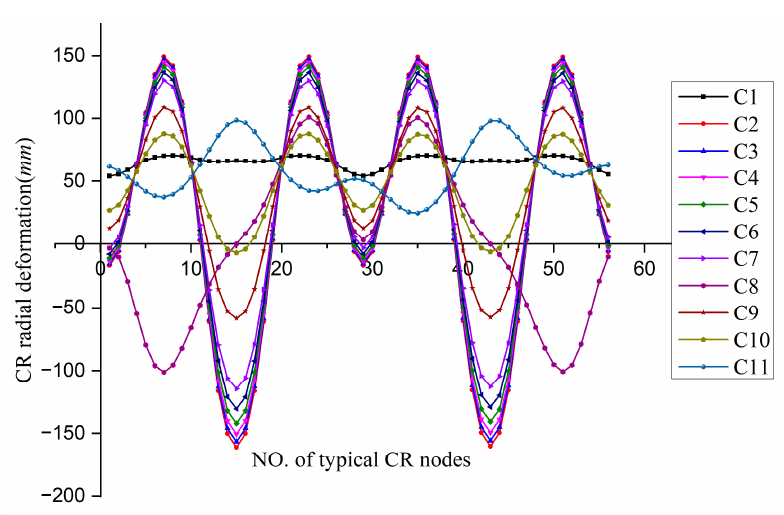
Figure 17. Radial deformation Ux of CR under local coordinate system at each step.